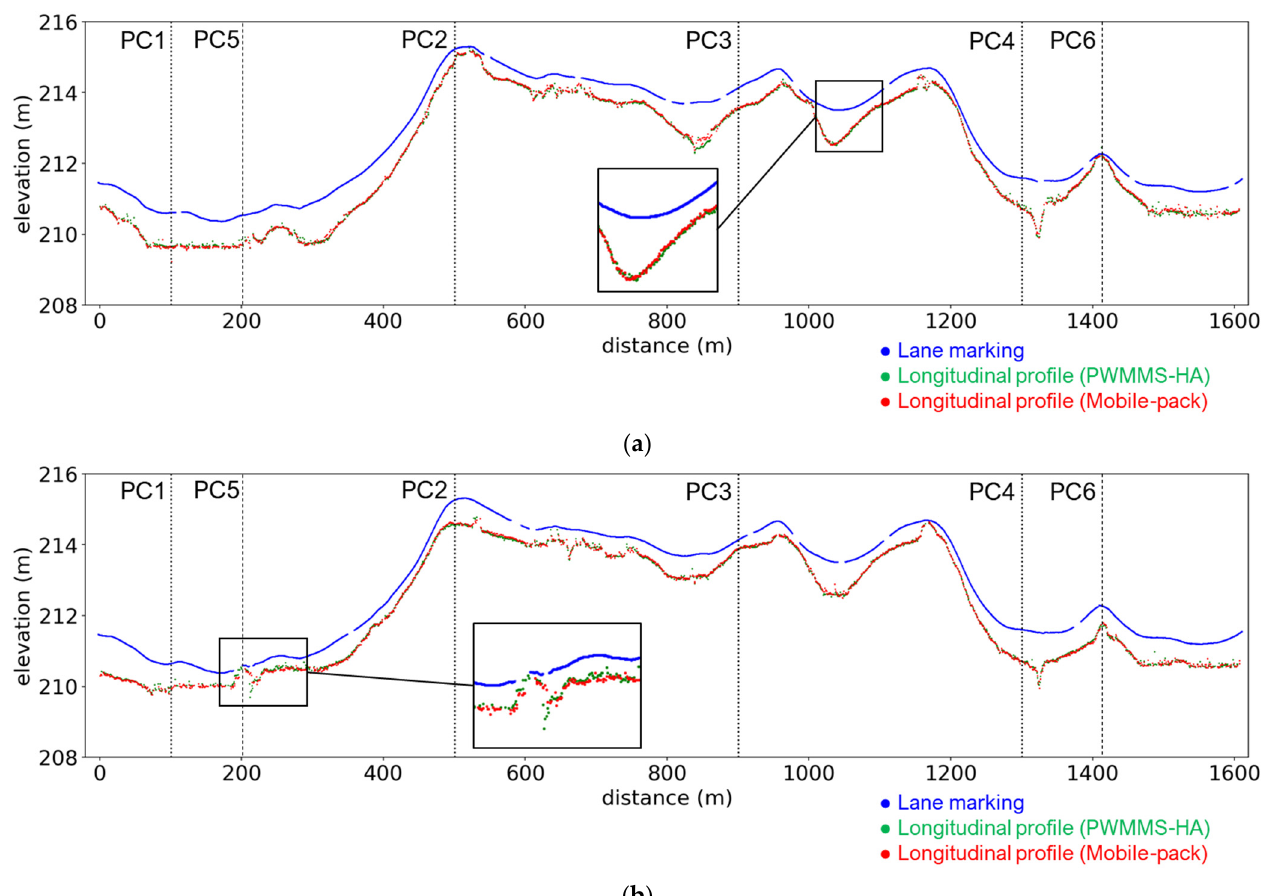
Figure 20. Longitudinal profiles from PWMMS-HA and Mobile-pack data together with the detected lane marking showing: ( a ) the ditch and road edge line on the left and ( b ) the ditch and road edge line on the right when driving eastbound.